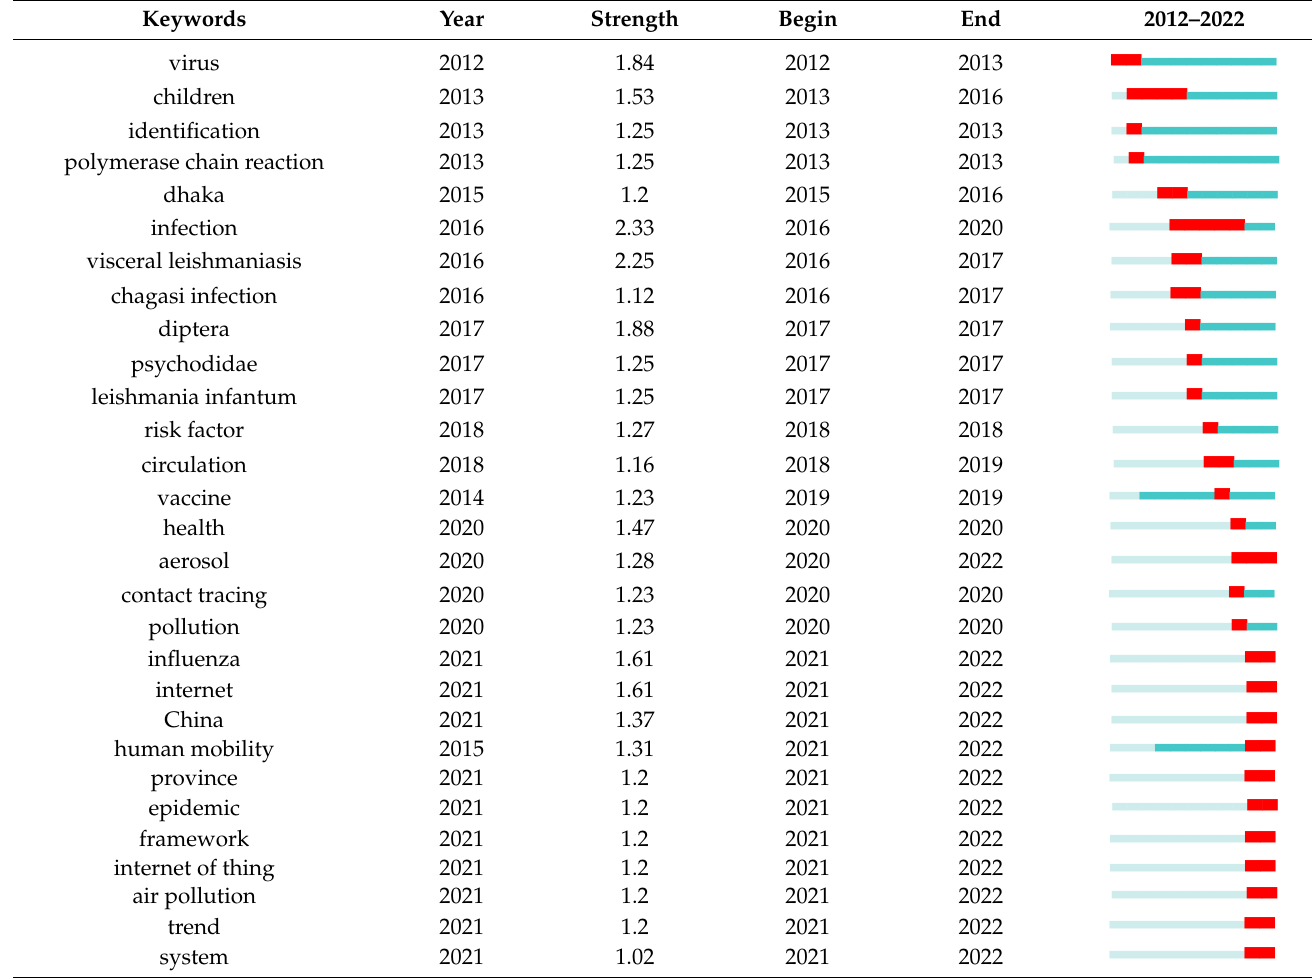
Table 11. Top 29 keywords with the deepest citation bursts. the length of the burst.